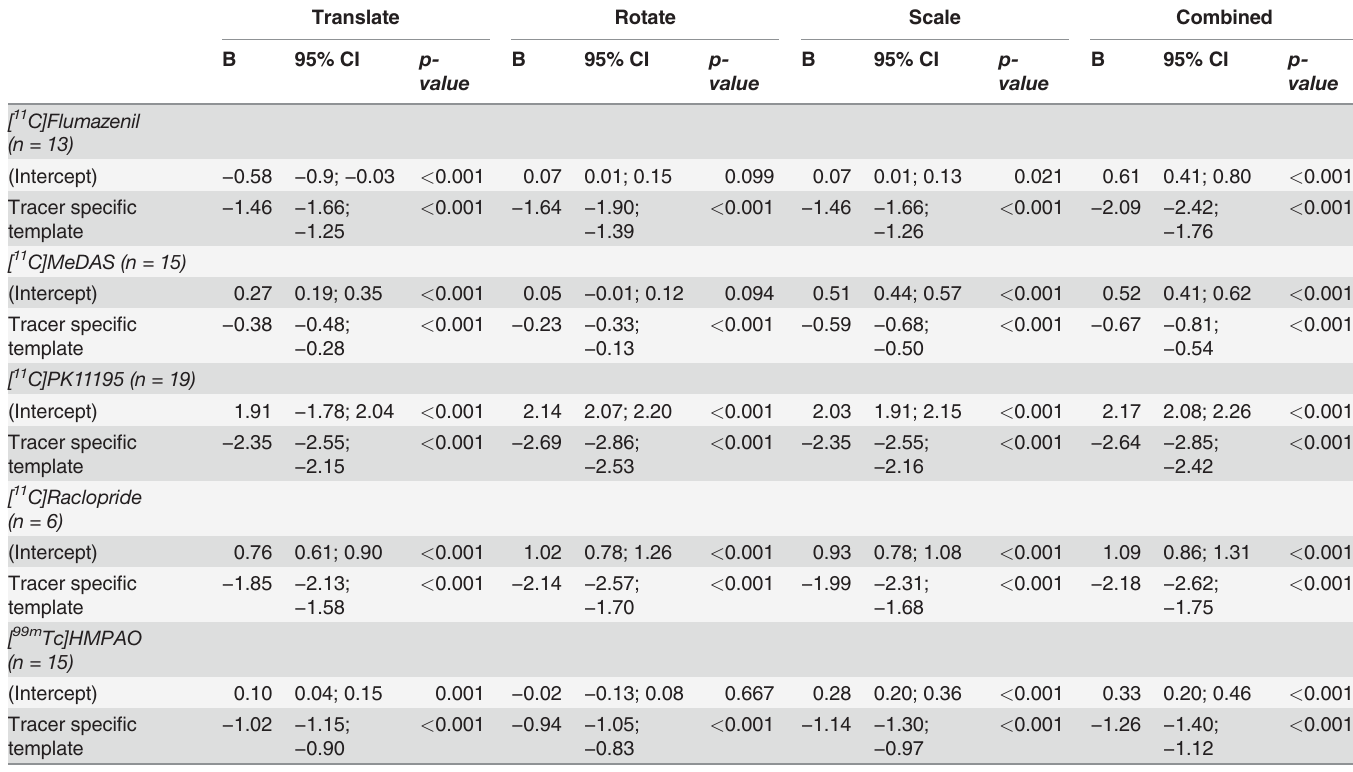
Table 4. Registration accuracy error: tracer specific template vs. “ standard template ” ([ 18 F]FDG template).